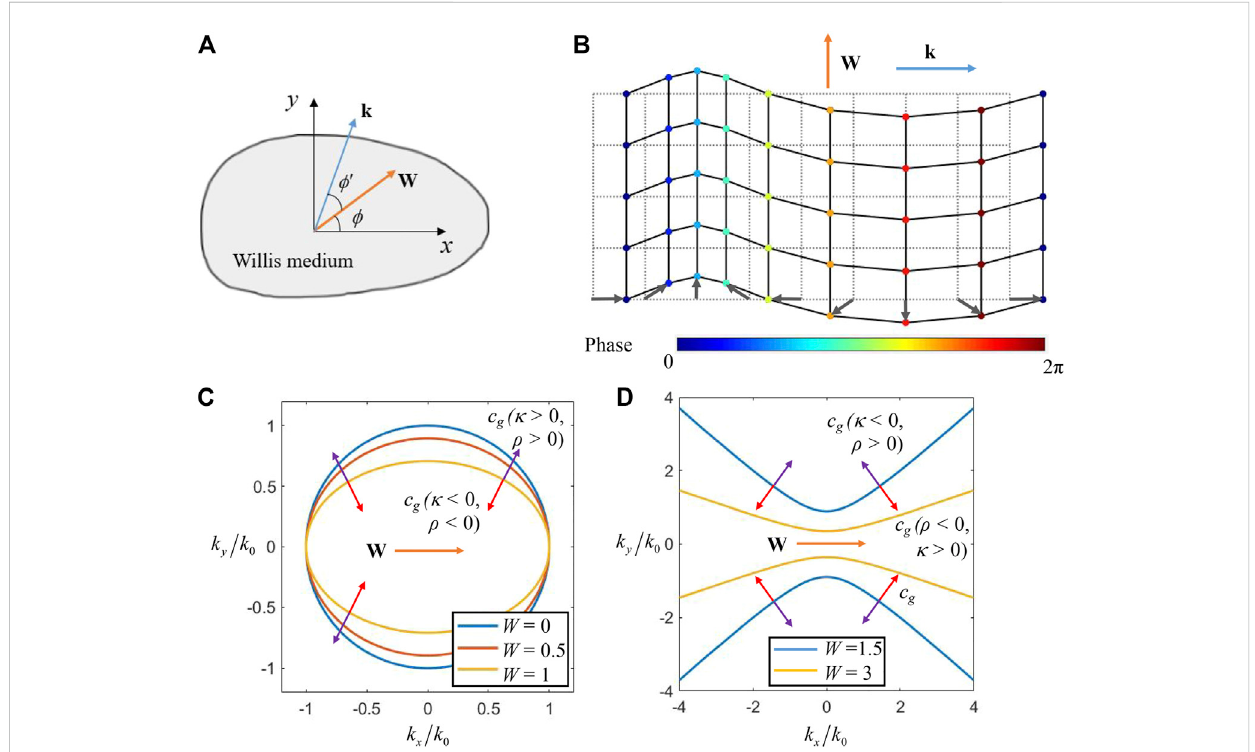
(cid:7)(cid:7)(cid:7) (cid:20) ρ / κ . The purple arrows denote the group